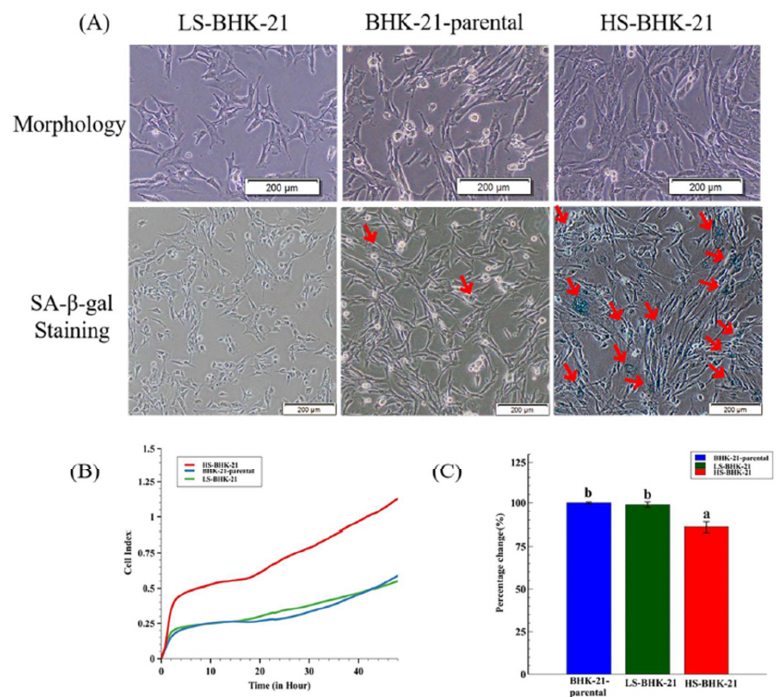
Figure 3. The different SA- β -gal staining property and the virus production of subclonal BHK-21 cells. ( A ) Cell morphology and the SA- β -gal staining results for LS-BHK-21, parental and the HS-BHK-21 cells. The cells were imaged with 400× microscope, and the scale bar shows 200 µm. ( B ) The adhesion properties and cell events of the parental and subclonal cells are showed as cell index curve which is measured by RTCA iCELLigence™. ( C ) The particular BEFV titer (48 h.p.i.) cultured by the parental and subclonal cells were compared to the BHK-21-parental group and showed as percentage. Fold change means with different letters are significantly different (Tukey’s HSD, p < 0.05).